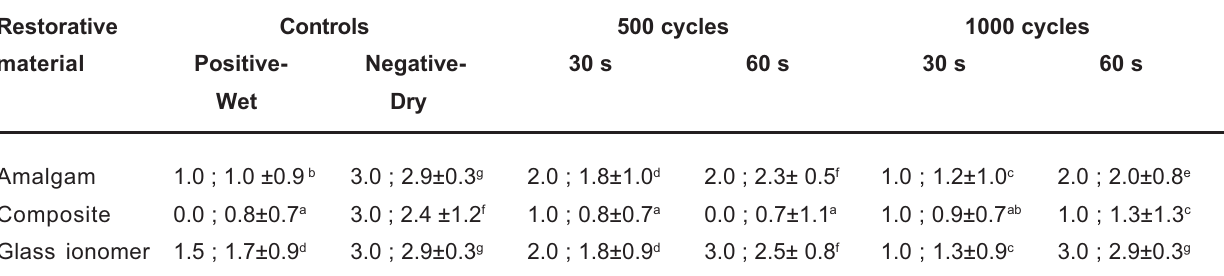
TABLE 1- Microleakage results for enamel margins